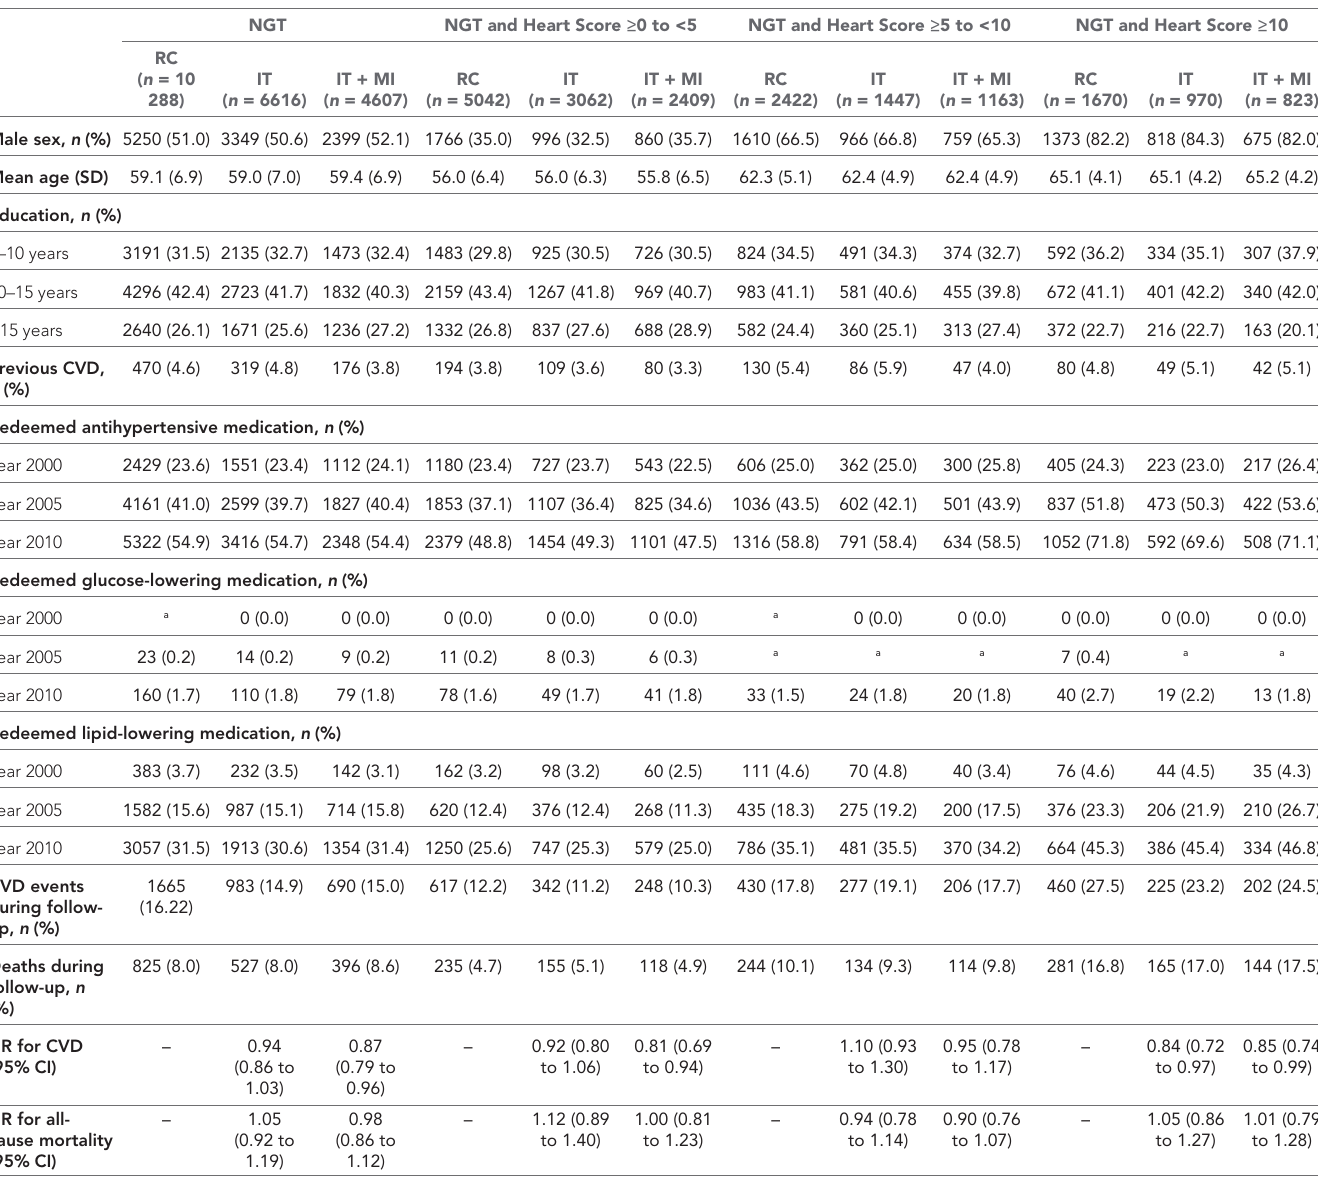
Table 2 Characteristics of individuals with normoglycaemia following screening in the ADDITION- Denmark study ( n = 21 451), by treatment